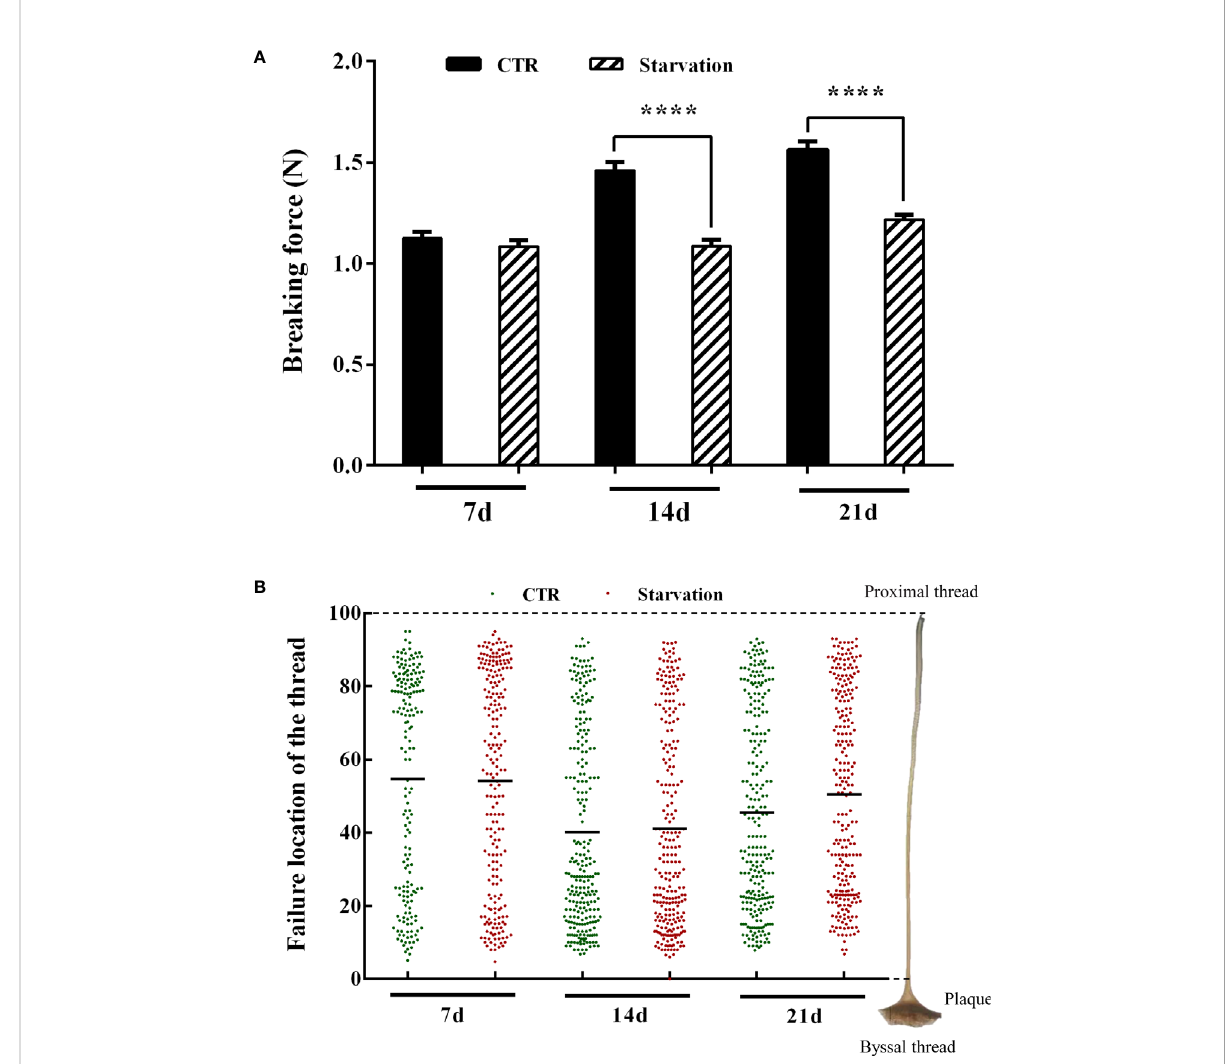
FIGURE 3 Effects of 21 days of starvation on (A) breaking force of the byssal thread and (B) failure location in the mussel M. coruscus . Each green dot and the red dot represent a thread breaking force test measurement. Each green dot and the red dot on the Y-axis corresponds to the breakpoints of a single byssal thread on the right side of the diagram. The value 100 on the Y-axis represents the proximal region of the thread, and the value 0 on Y-axis represents the distal region of the thread (close to the plaque). The amount of byssal breaking force measurements was as follows: 184 (7d, CTR), 221 (7d, starvation), 256 (14d, CTR), 256 (14d, starvation), 253 (21d, CTR) and 256 (21d, starvation). Asterisks indicate signi fi cant differences between starvation groups and CTR groups. **** p <